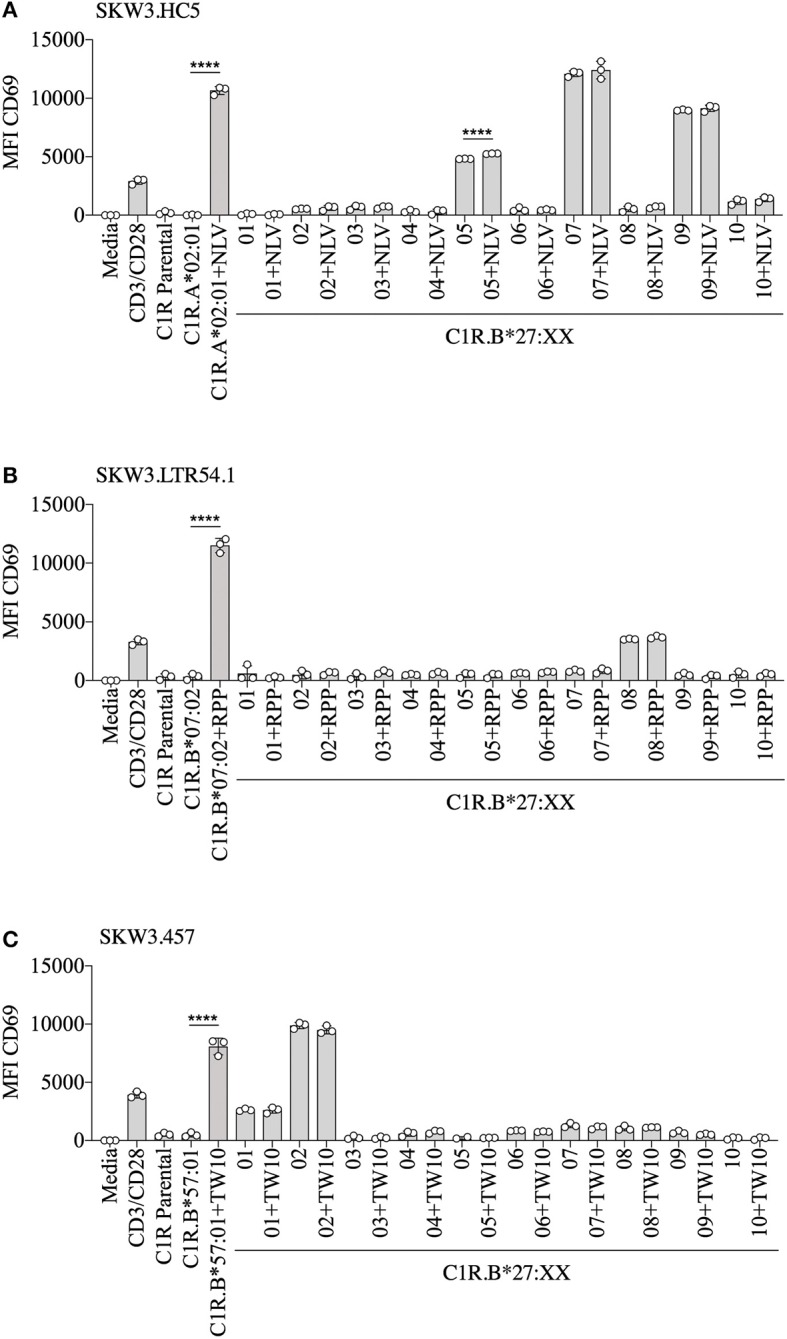
HLA-B27 presentation of cognate viral peptide does not confer additional immunogenicity. (A) SKW.HC5 (i.e., CMV A2NLV), (B) SKW3.LTR54.1 (i.e., EBV B7RPP), and (C) SKW3.457 (i.e., HIV-1 B57TW10) TCR activation was measured using cell surface CD69 upregulation after 16–20 h stimulation with HLA-restricted C1R transfectants ± cognate peptide and a panel of C1R.B27 transfectants. CD69 MFI values were calculated after gating on FSC vs. SSC, single cells, GFP+ cells, live cells, CD3+CD8+ cells then CD69+ cells. Mean ± SEM are shown (single experiment with triplicate data). Statistical significance using unpaired Student's t-test is denoted by ****p < 0.0001.